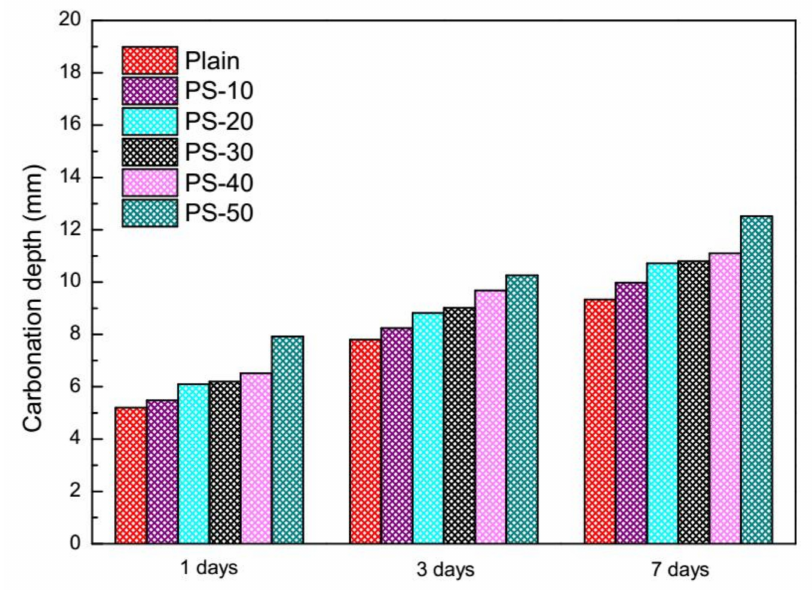
Figure 6. Carbonation depth of cement mortars with phosphorus slag at di ff erent exposure